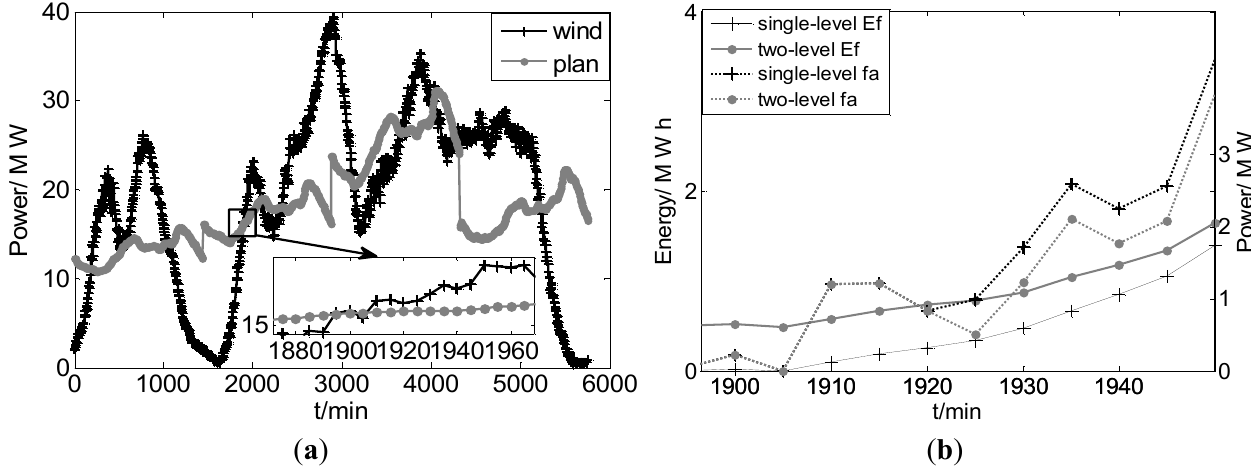
Figure 14. Minute 1920 of the wind power plan and operating states of the fly wheel. ( a ) Four days wind power and plan; ( b ) Operating states of the fly wheel.